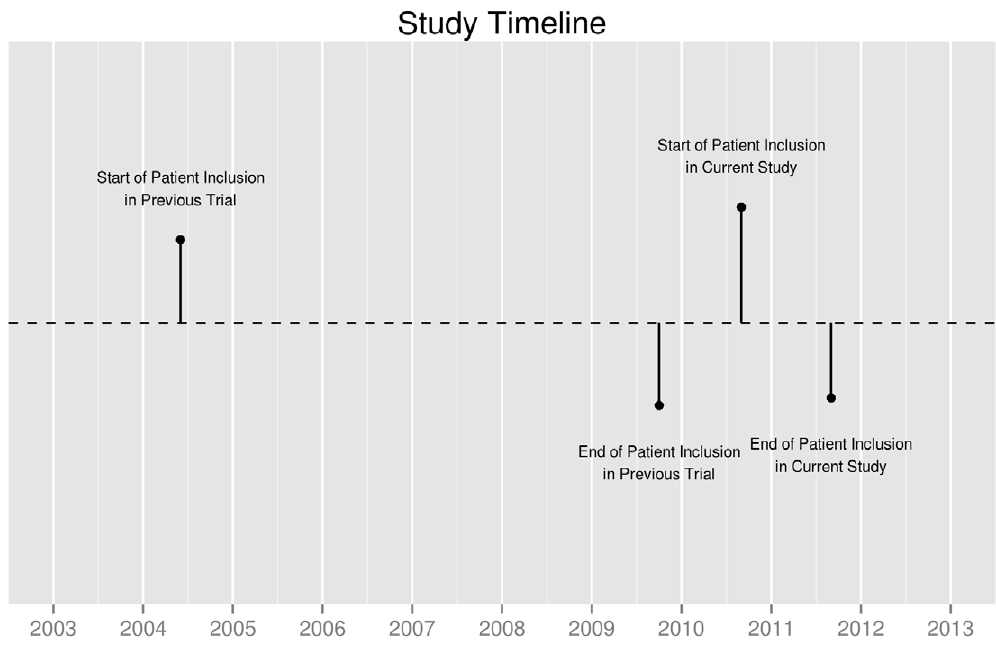
Figure 1. Study Timeline.